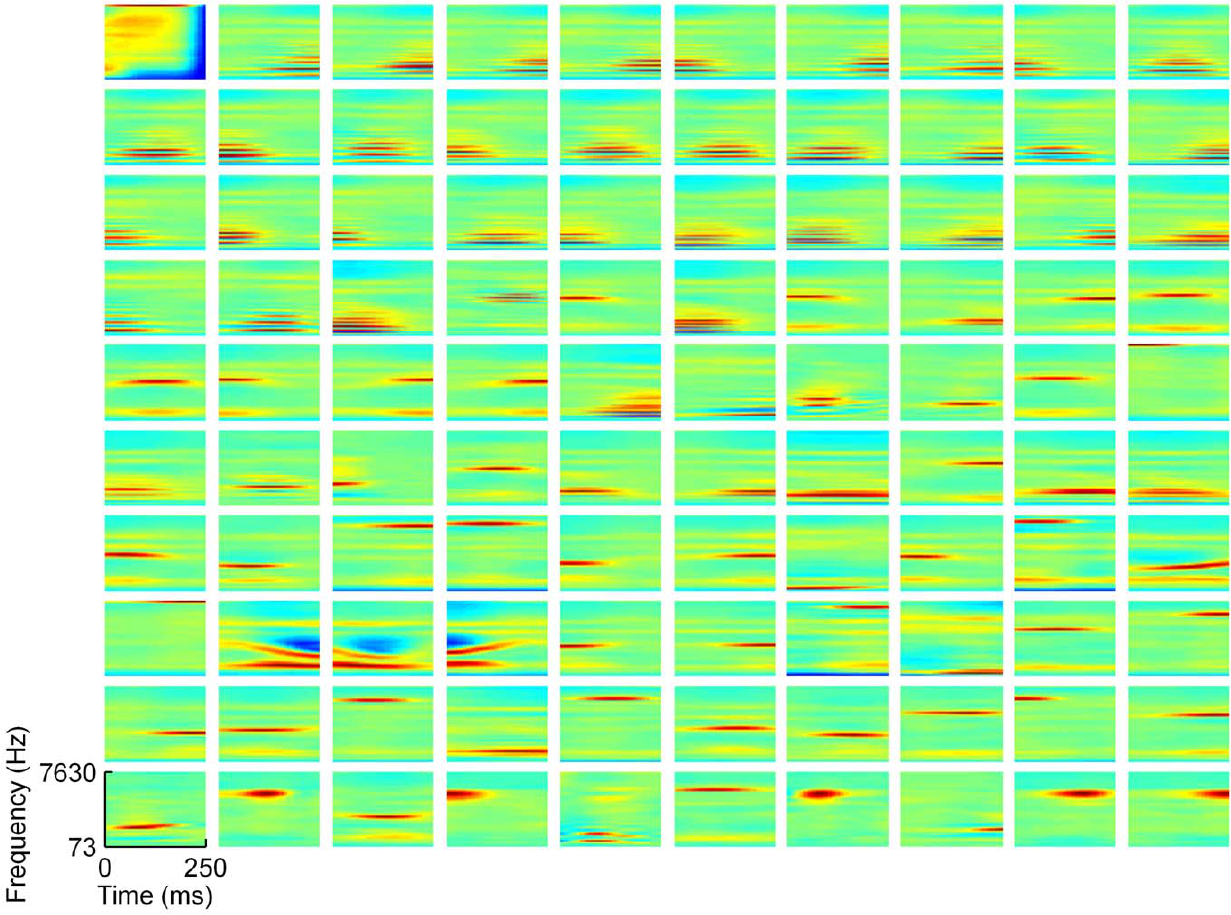
Figure 2. A half-complete sparse coding dictionary trained on cochleogram representations of speech. This dictionary exhibits a limited range of shapes. The full set of 100 elements from a half-complete, L0-sparse dictionary trained on cochleograms of human speech resemble those found in a previous study [17]. Nearly all elements are extremely smooth, with most consisting of a single frequency subfield or an unmodulated harmonic stack. Each rectangle can be thought of as representing the spectro-temporal receptive field (STRF) of a single element in the dictionary (see Methods for details); time is plotted along the horizontal axis (from 0 to 250 ms), and log frequency is plotted along the vertical axis, with frequencies ranging from 73 Hz to 7630 Hz. Color indicates the amount of power present at each frequency at each moment in time, with warm colors representing high power and cool colors representing low power. Each element has been normalized to have unit Euclidean length. Elements are arranged in order of their usage during inference ( i.e. , when used to represent individual sounds drawn from the training set) with usage increasing from left to right along each row, and all elements of lower rows used more than those of higher rows.